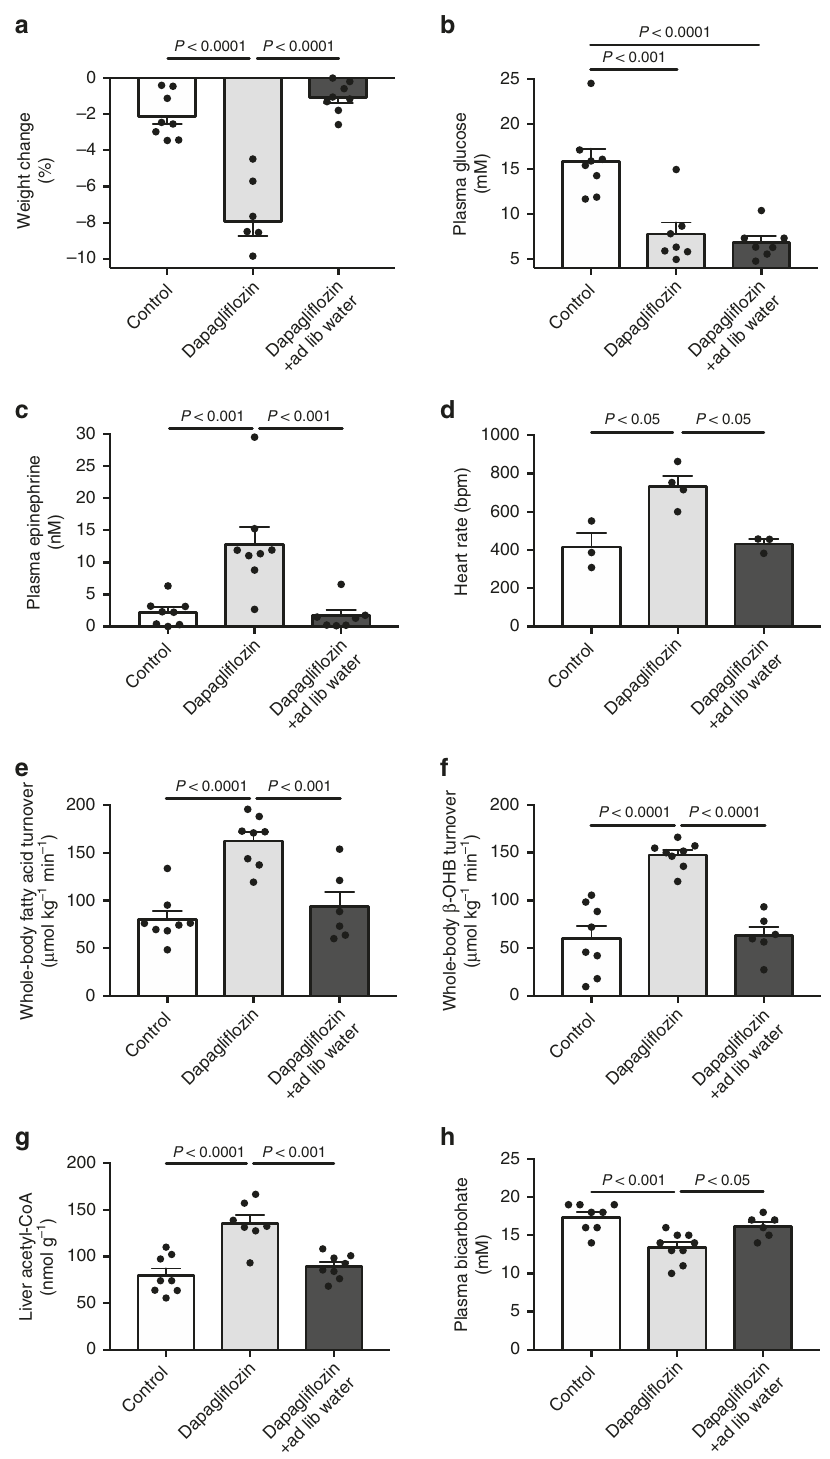
Fig. 3 Dapagli fl ozin (1 mg kg − 1 ) causes ketoacidosis in a rat model of type 2 diabetes. a Weight change. b , c Plasma glucose and epinephrine concentrations. d Heart rate. e , f Whole-body fatty acid and β -OHB turnover. g Liver acetyl-CoA. h Plasma bicarbonate. In all panels, data are the mean ± S. E.M., with comparisons by ANOVA with Bonferroni ’ s multiple comparisons test rates of WAT lipolysis and observed 2 – 3 fold increases in rates of plasma corticosterone and catecholamines, WAT lipolysis, fatty acid and glycerol turnover, as well as hepatic acetyl-CoA hepatic acetyl-CoA content, and hepatic ketogenesis in both content. These increases in WAT lipolysis were associated with healthy control and T2D rats, demonstrating that volume increased HPA axis activity, as well as plasma catecholamine depletion is necessary to provoke ketoacidosis with SGLT2i concentrations. Volume replacement by saline infusion or ad lib treatment. The requirement for volume depletion to generate access to water throughout the study prevented these increases in ketoacidosis in SGLT2i treated rats could also explain why NATURE COMMUNICATIONS| (2019) 10:548